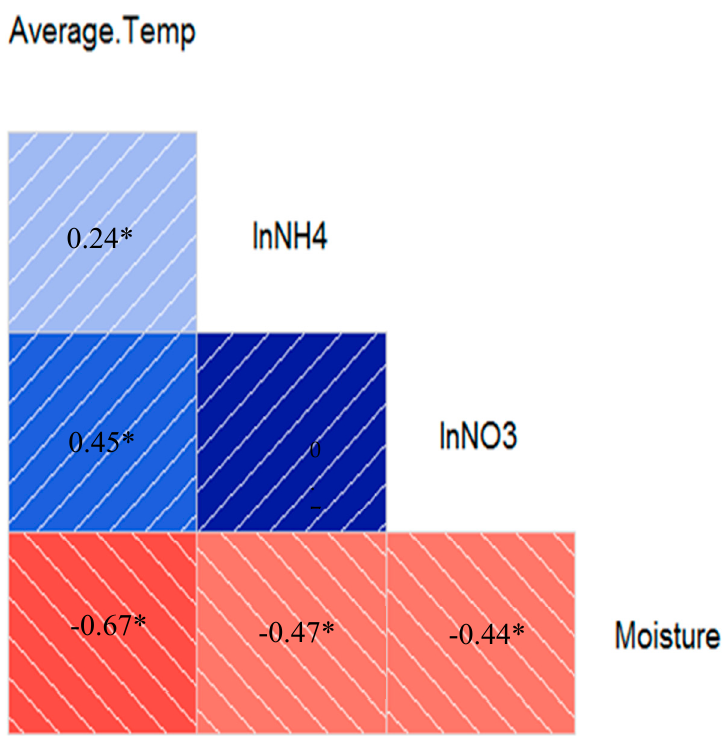
Figure A2. Total monthly precipitation and mean monthly temperature data from Vancouver International airport weather station [18].